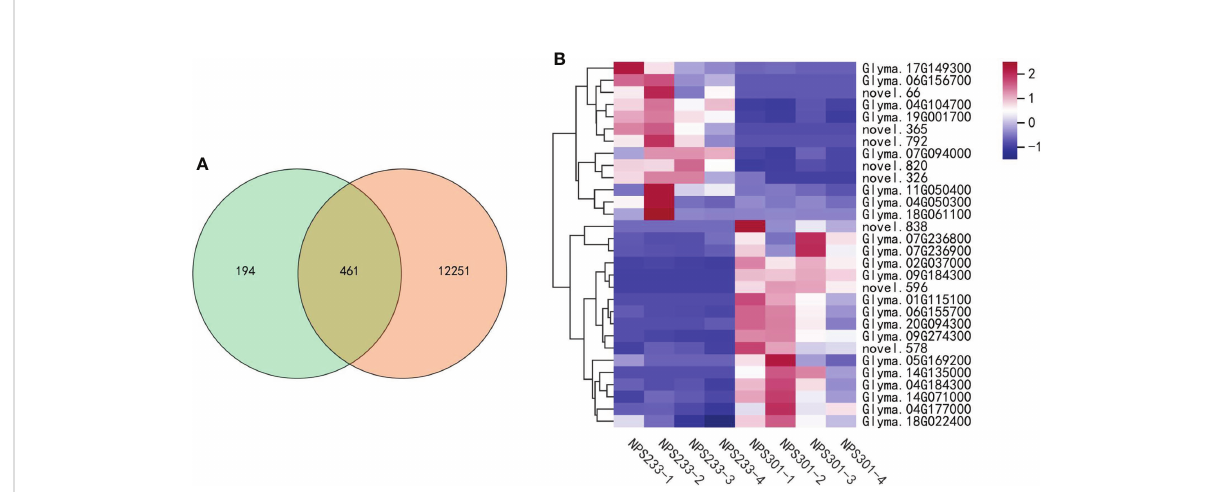
FIGURE 6 Candidate DEG set belonging to the lipid and amino acids biosynthesis pathways. (A) Venn diagram depicting the speci fi c DEGs between the four compared groups. (B) Heatmap showing the expression patterns of the candidate genes involved in lipid and amino acids biosynthesis pathways. The gene per row is Z-score